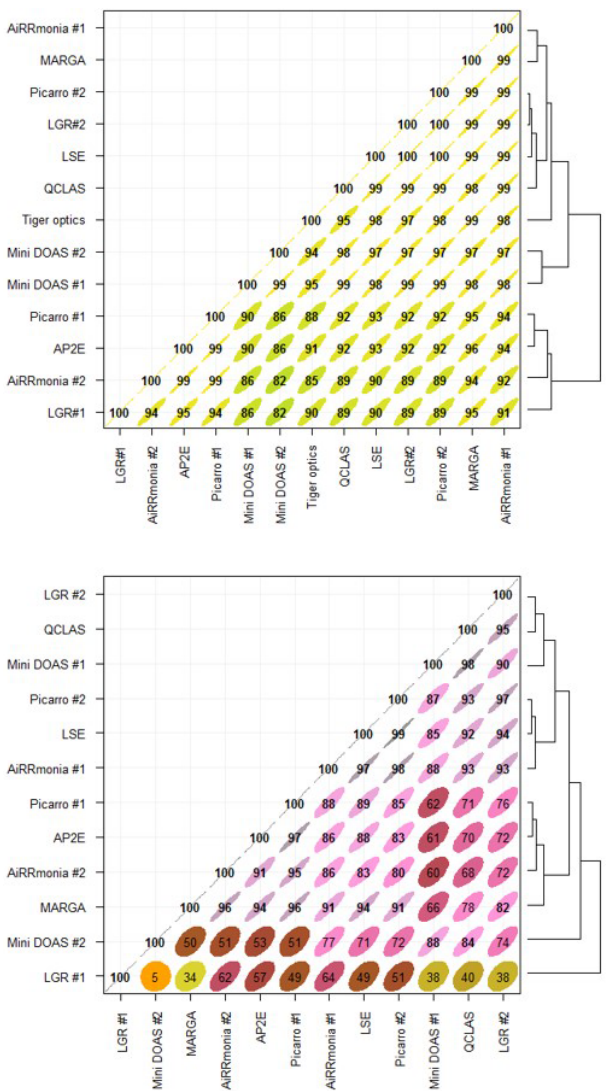
Figure 10. Least-squares regression correlation coefficients be- tween instruments clustered into a matrix based on their Euclidean distances (black lines on RHS of the figure) for the (a) whole range and (b) when NH 3 < 10ppb of the ensemble median for the pe- riod of 23 August 2016, 00:00, and 29 August 2016, 01:00, based on their hourly averages. Graph generated using OpenAir package (Carslaw and Ropkins, 2012). Note the Tiger Optics is excluded from panel (b) . The colour scale relates to the magnitude of the cor- relation coefficient.